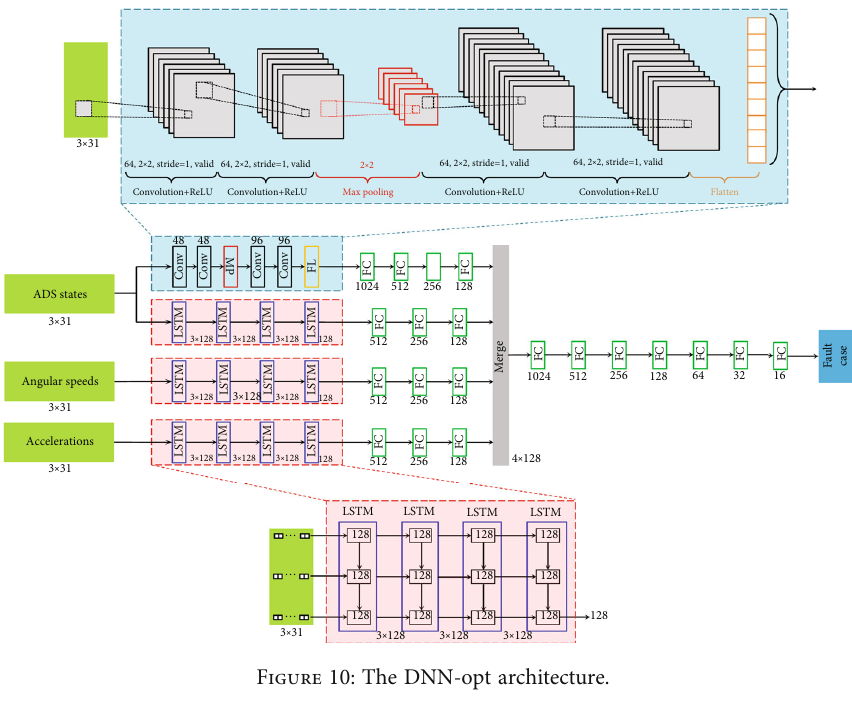
Figure 10: The DNN-opt architecture.